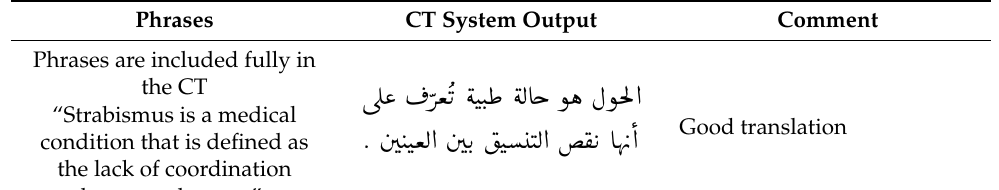
Table 7. The qualitative